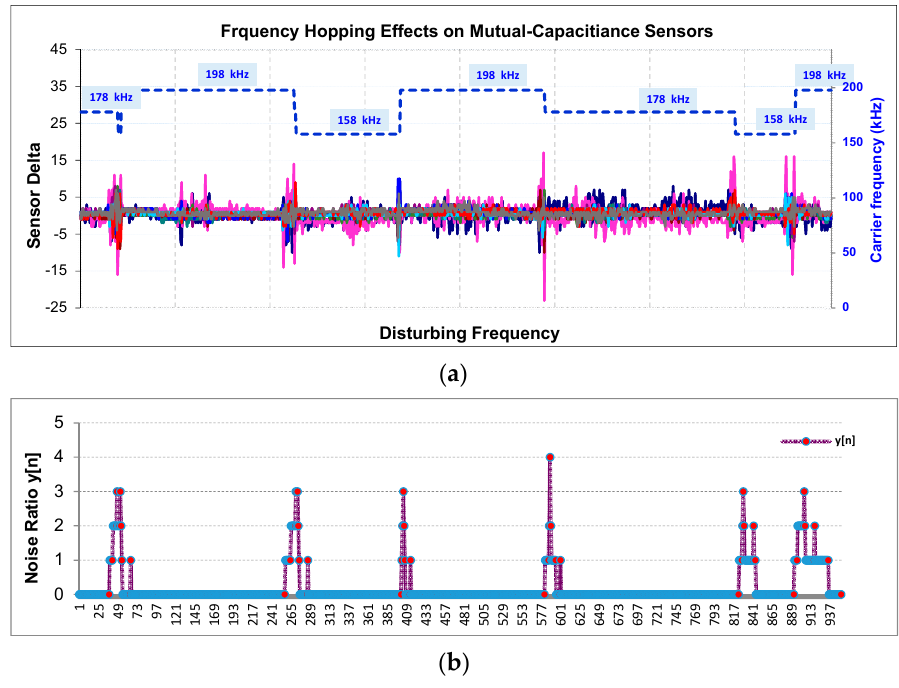
Figure 9. illustrates the frequency hopping effect for all sensors. When y[n] reaches 3 , the carrier frequency is altered to a noiseless band (blue dash-line). ( a ) The disturbed mutual-capacitance sensor; ( b ) the noise ratio.